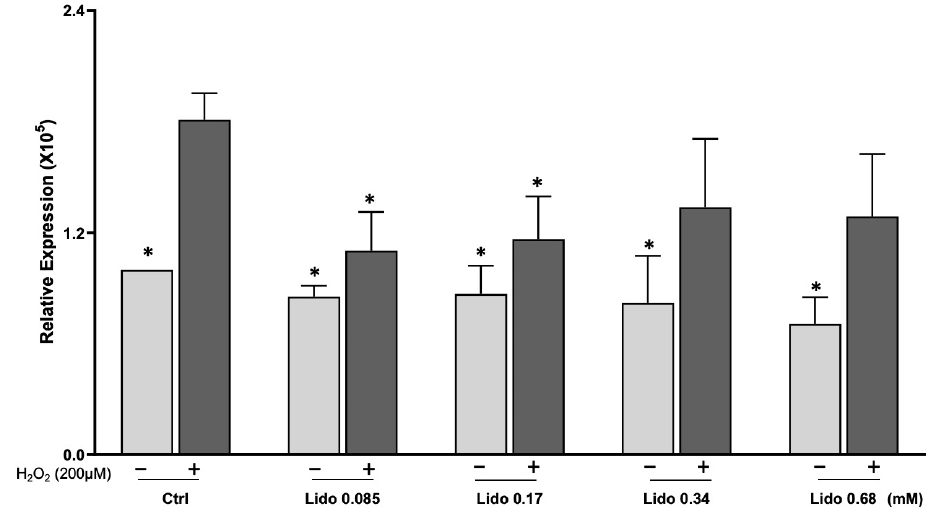
Figure 7. Lidocaine prevents ROS generation by H 2 O 2 . AC16 human cardiac myocytes were seeded in 96-well plates and were pretreated with indicated concentrations of lidocaine for 3 h before 30 min incubation with 10 µ M DCFH-DA. H 2 O 2 was added to the final 200 µ M for recording the fluorescence of hydroxy radical formation. The bar graphs represent the means ± SD from 3 independent experiments. * indicates statistical significance ( p < 0.05) from H 2 O 2 -treated alone group as determined by two-way ANOVA.